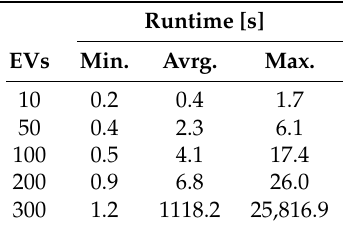
Table 2. Runtime of the optimizations that have to be performed for the charging scheduling in the main scenario on one day for different numbers of EVs per day. Shown are the minimum, average and maximum values over the 35 days. The lead time is set to 2 intervals and the trading unit to 100kW. Runtime [s] EVs Min.